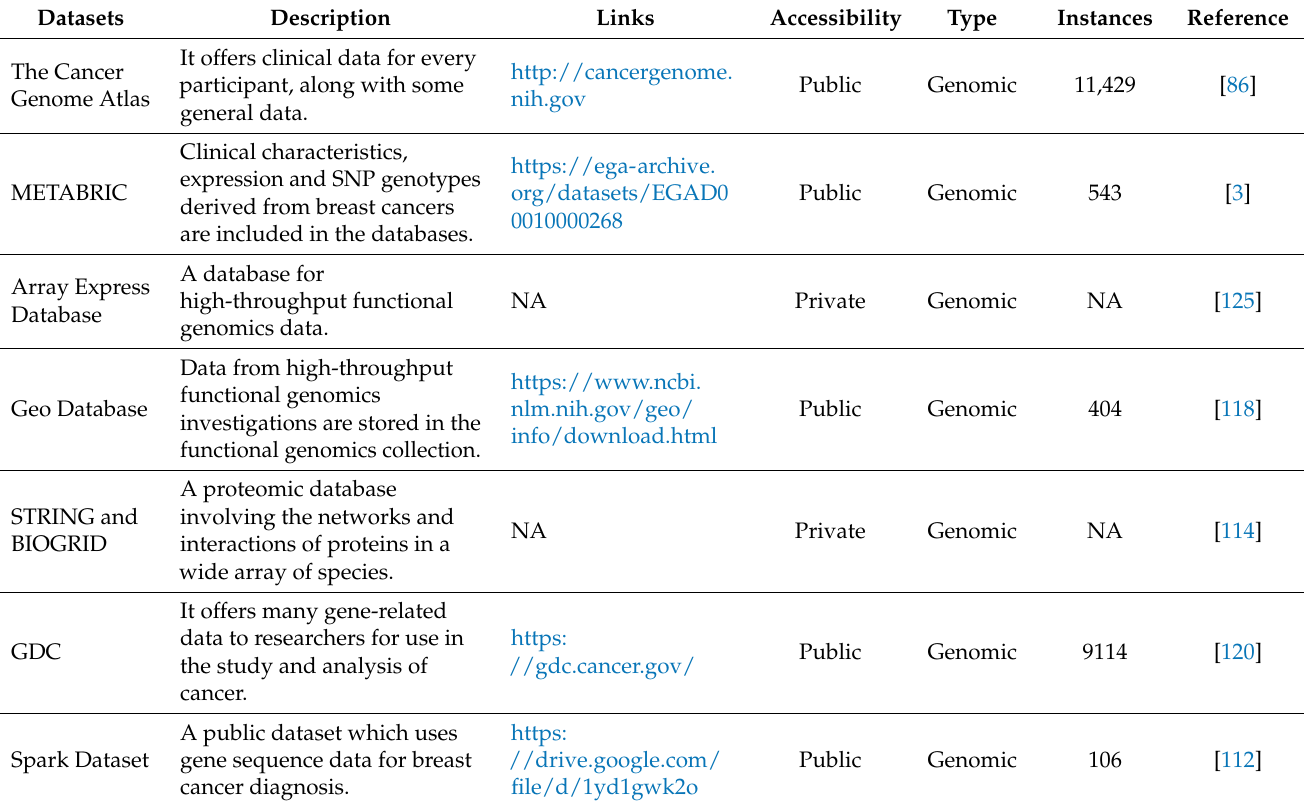
Table 7. Genomic Datasets used for breast cancer